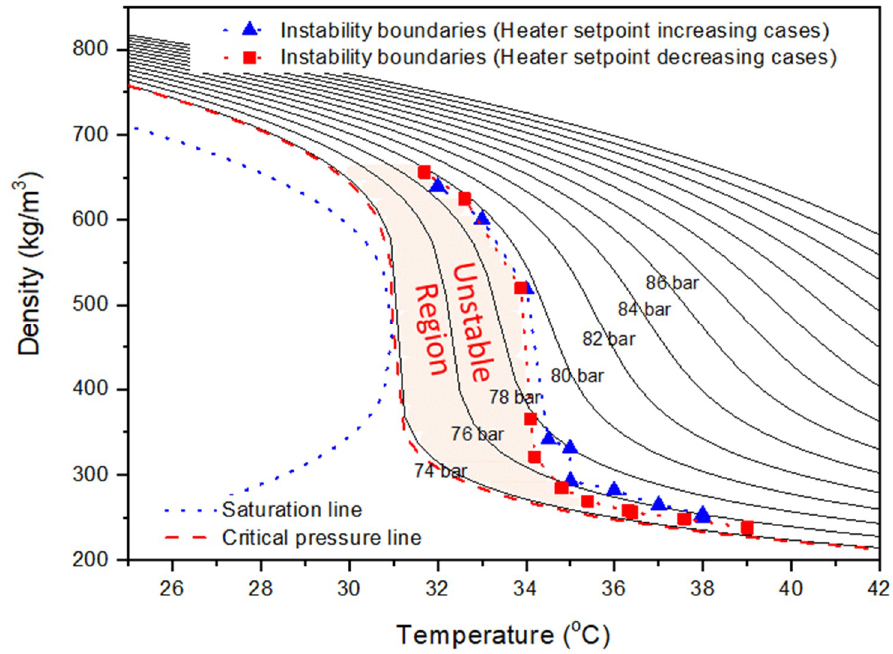
Figure 8. Temperature–density diagram of CO 2 with an unstable region.